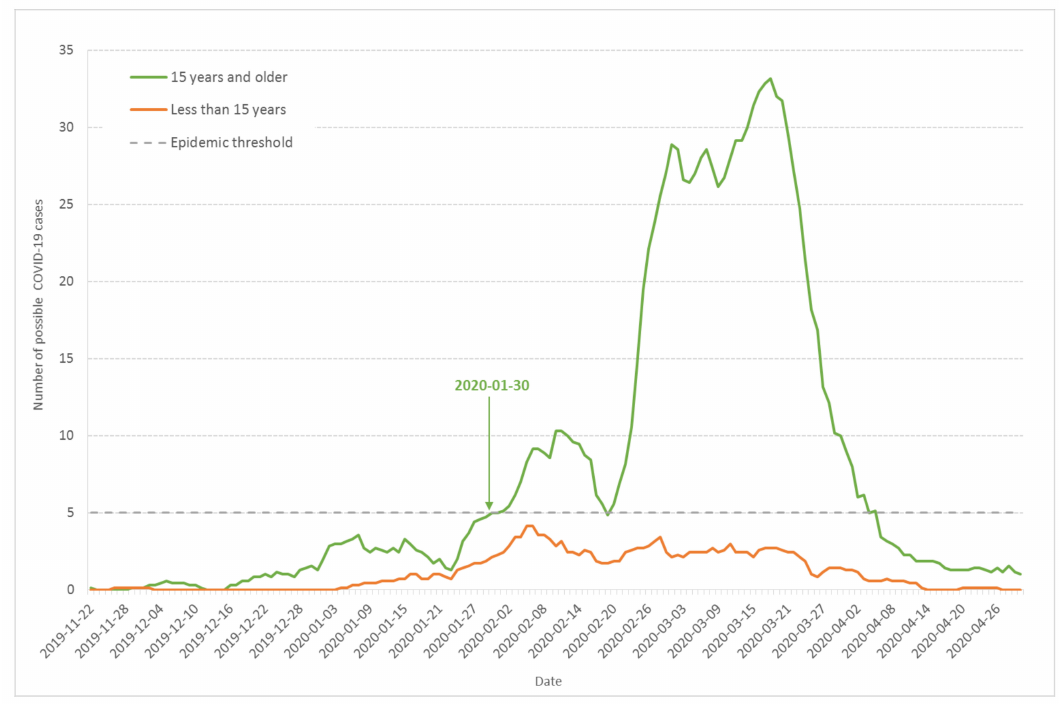
Figure 4. Seven-day moving average of daily incidence of possible COVID-19 cases based on the onset day of the first COVID-19 symptoms for children less than 15 years old (orange line) and adults and children above 15 (green line) from the population-based survey of Haut-Rhin